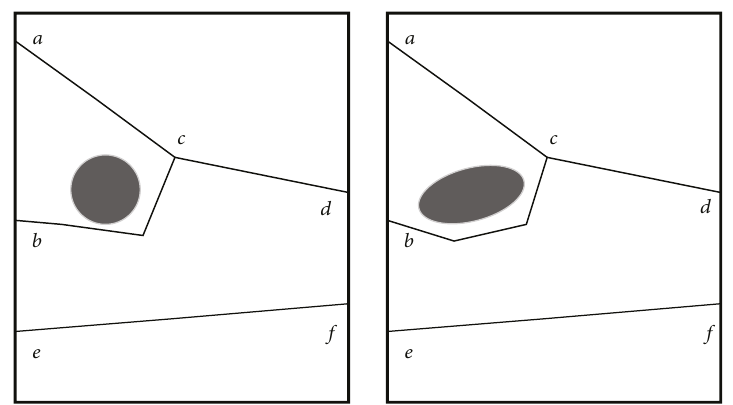
Figure 1: Structure scheme under weather